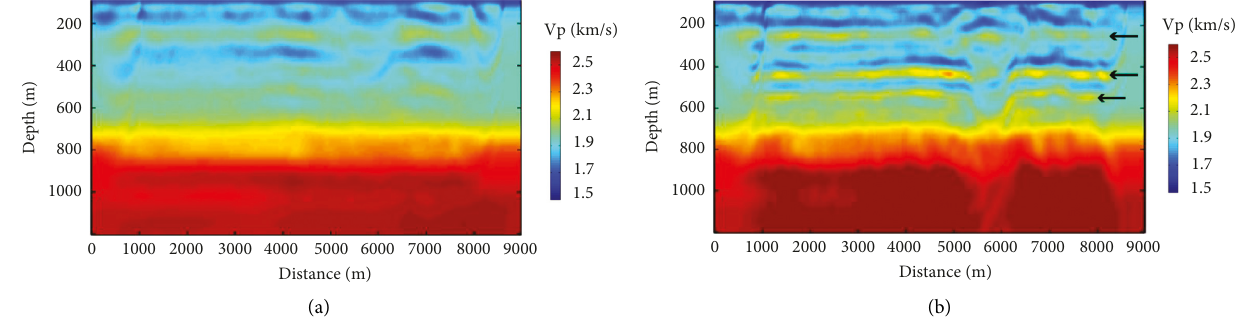
Figure 8: (a) The inverted model of the L2-norm EWI and (b) the inverted model of the W2-norm EWI.